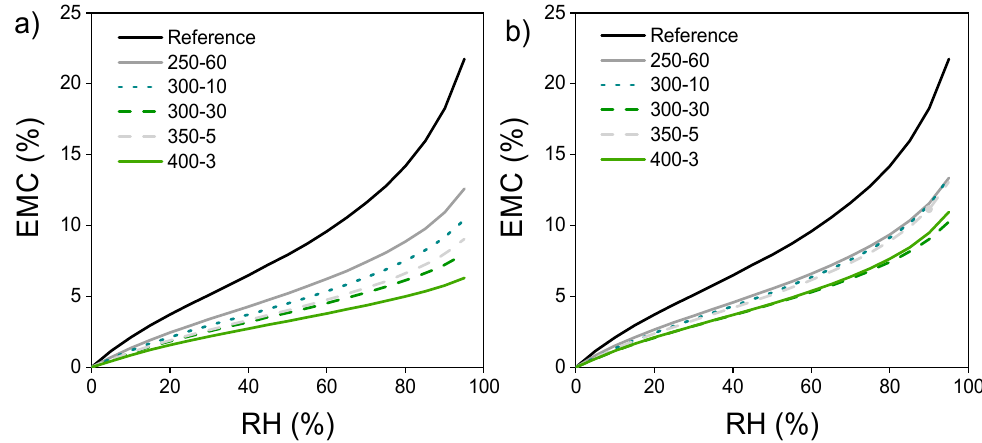
Figure 4. ( a ) Adsorption isotherms of surface and ( b ) pyrolysis zone between 0 and 95% RH.